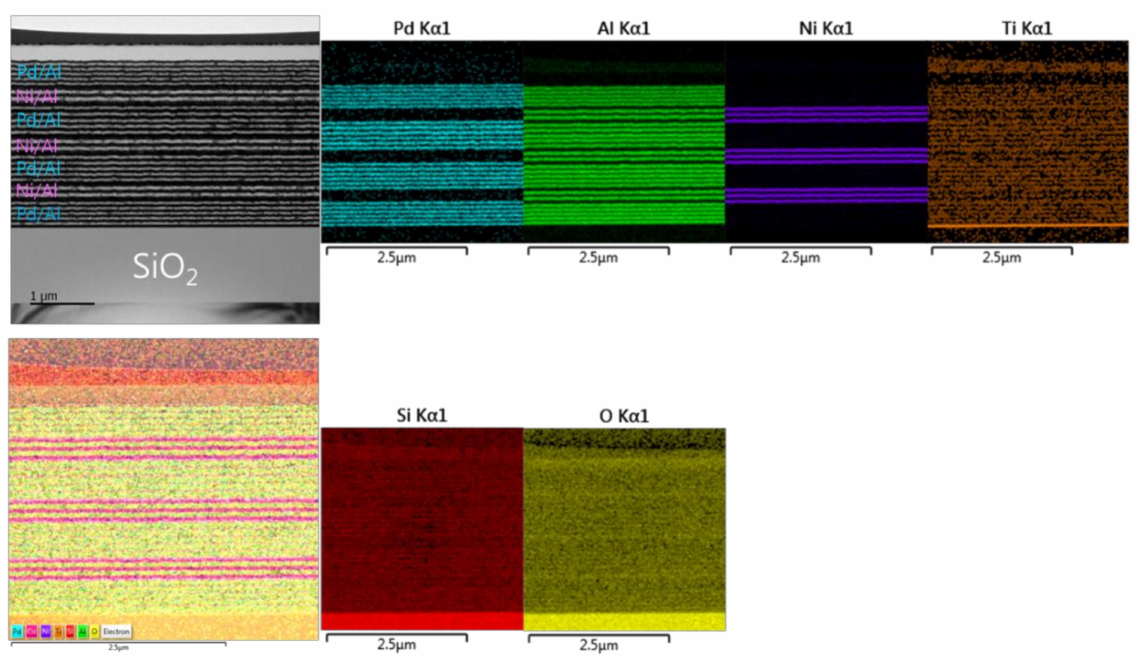
Figure 15. TEM cross section image ( upper left ) and the corresponding EDS elemental analysis ( upper right and lower left and right ) for the microstructural characterization of the as-deposited Pd/Al-Ni/Al MS-iRMS on the SiO 2 -coated